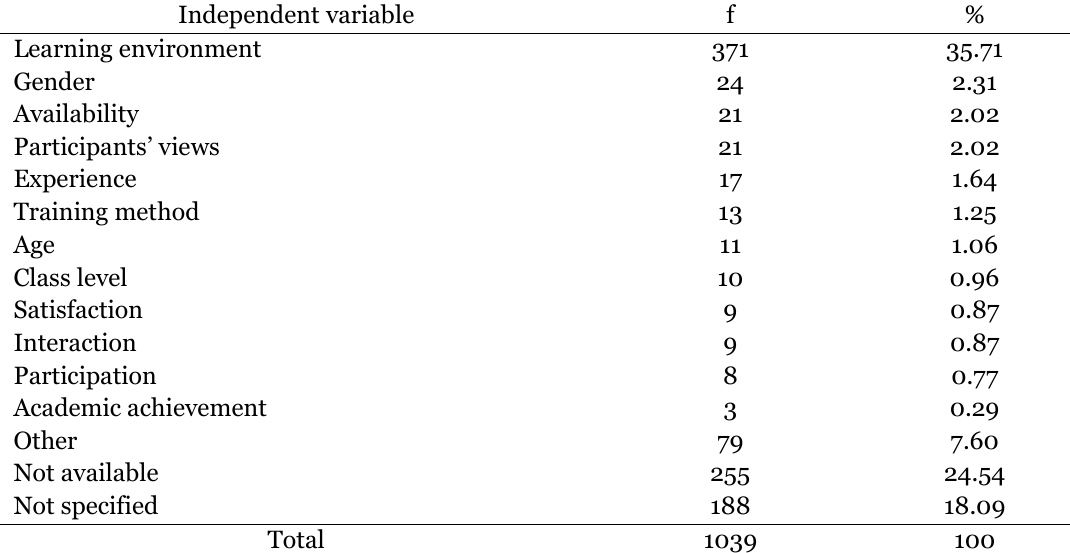
Distribution of Studies by Independent